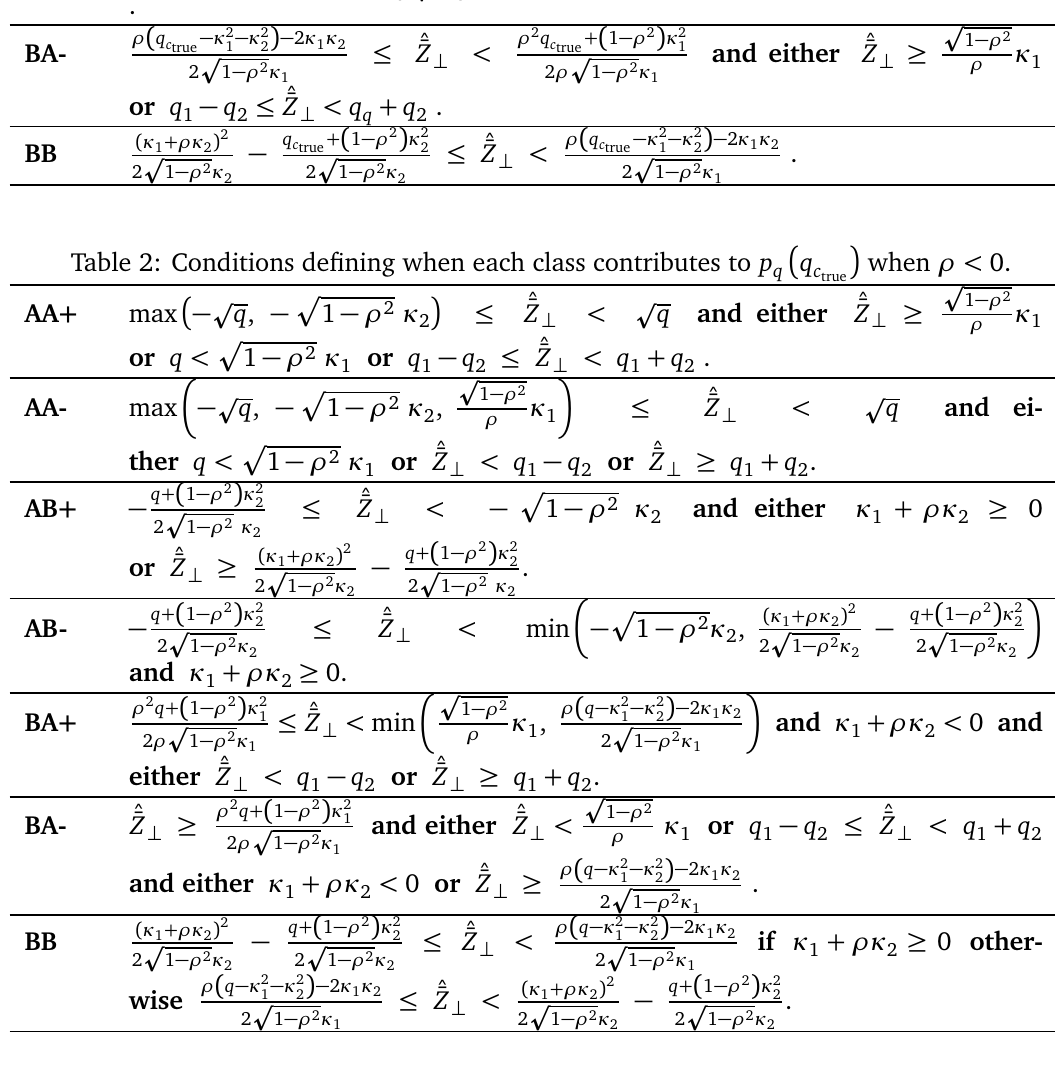
(cid:128) (cid:138) (cid:112) − (cid:112) q ≤ ˆ¯ Z , − 1 − ρ 2 κ c true 2 < q + q − q ≤ ˆ¯ Z or q . ⊥ 1 2 1 2